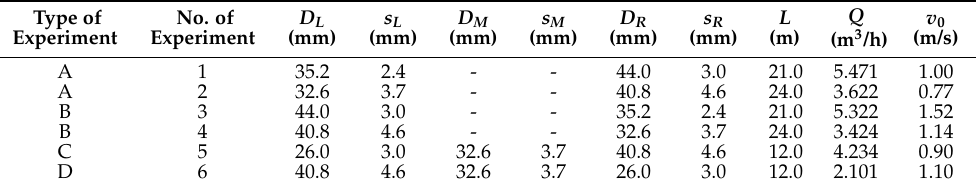
Table 1. Parameters of the pipes used in experiments.